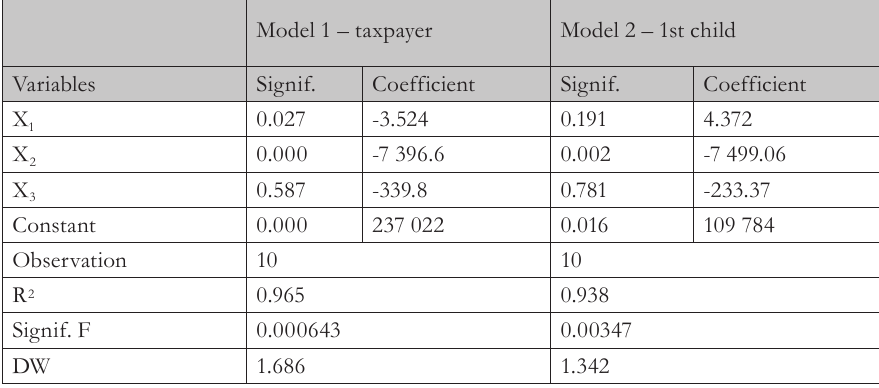
Tab. 4a – The Regression Analysis results. Source: own